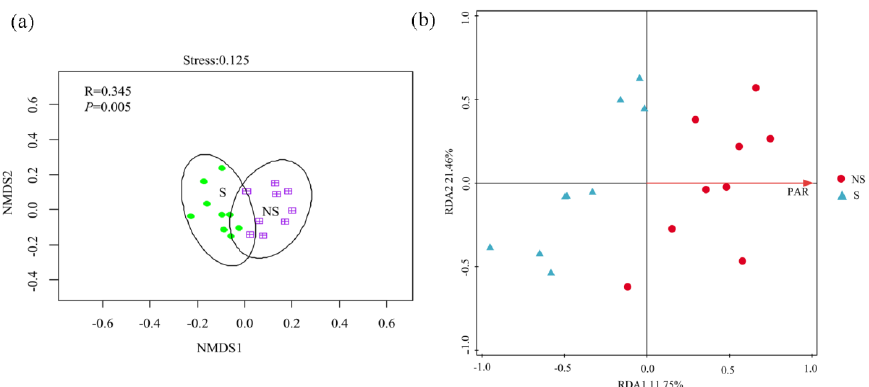
Figure 5. Beta diversity of bacterial communities based on Bray–Curtis distance (on OTU level) analyzed by NMDS ( a ) and redundancy analysis of the correlation between environmental factors and bacterial community structure ( b ).